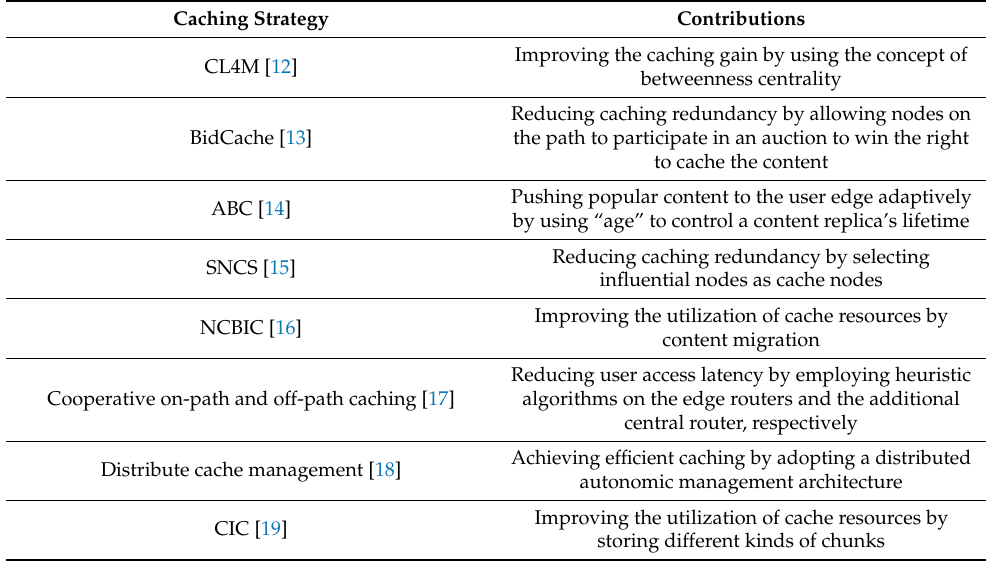
Table 1. Summary of contributions of the ICN caching strategies.